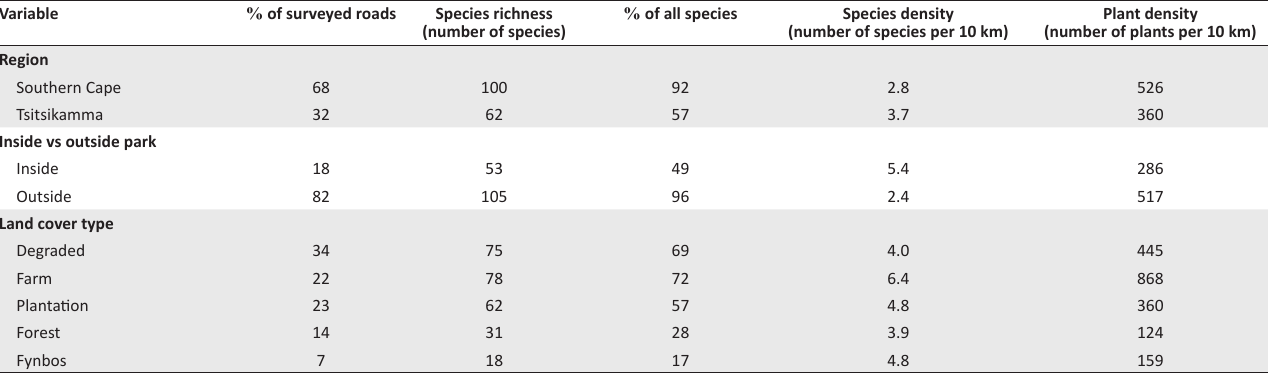
TABLE 2: Extent of roads and alien plant species richness, species density and plant density compared between regions, inside versus outside of the Garden Route National Park and land cover types.